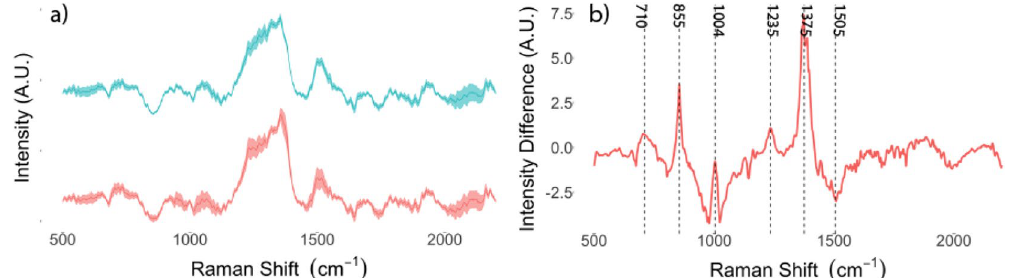
Figure 2. ( a ) Mean normalized Raman spectra and standard deviations (shaded areas) for infected (red) and uninfected (blue) urine samples captured on SERS-active filters. ( b ) Mean spectrum with standard deviation (ribbon) of infected samples centered and scaled on uninfected controls demonstrating discriminatory peaks at 710, 855, 1004, 1235, 1375 and 1505 cm -1 .